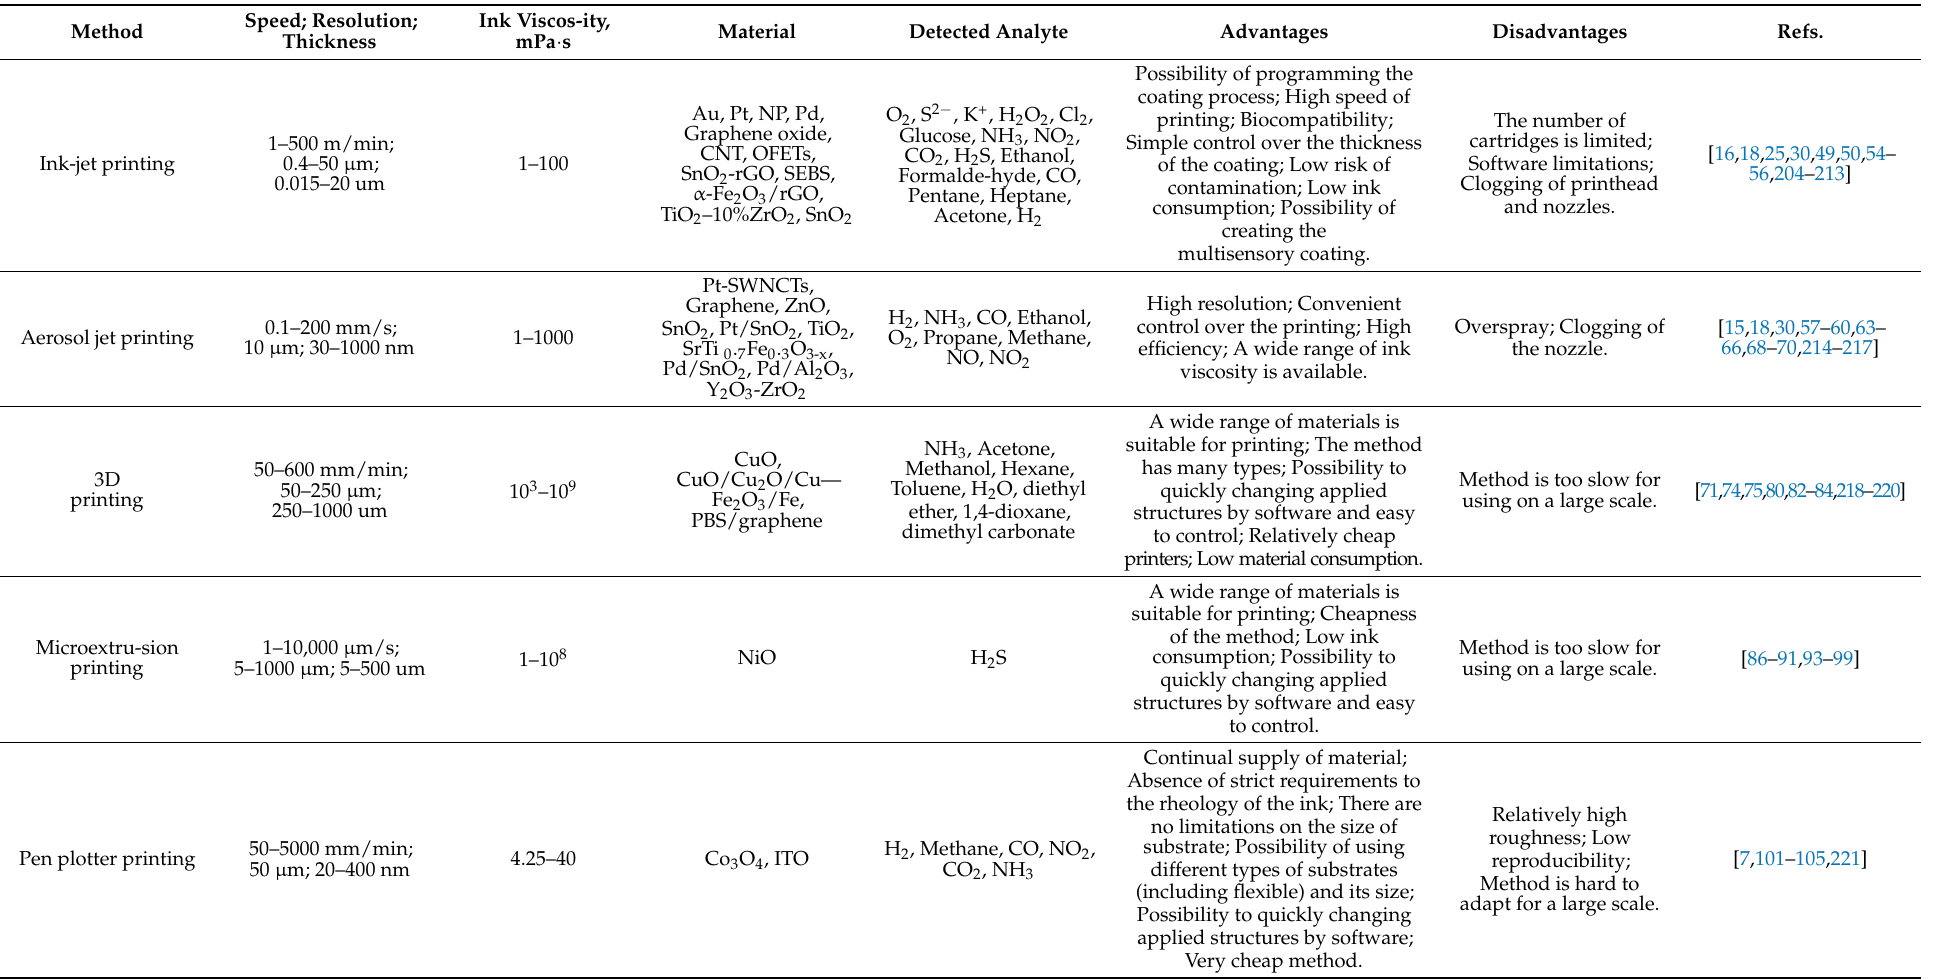
Table A1. The key characteristics of the printing technologies employed in gas sensor